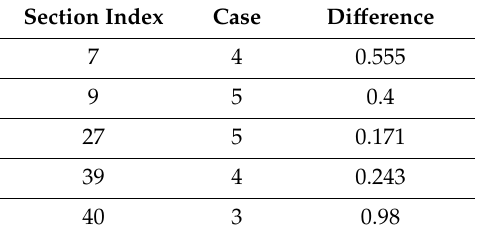
Table 3. Di ff erences between critical depths computed with ACPA and HEC-RAS for dataset 3.